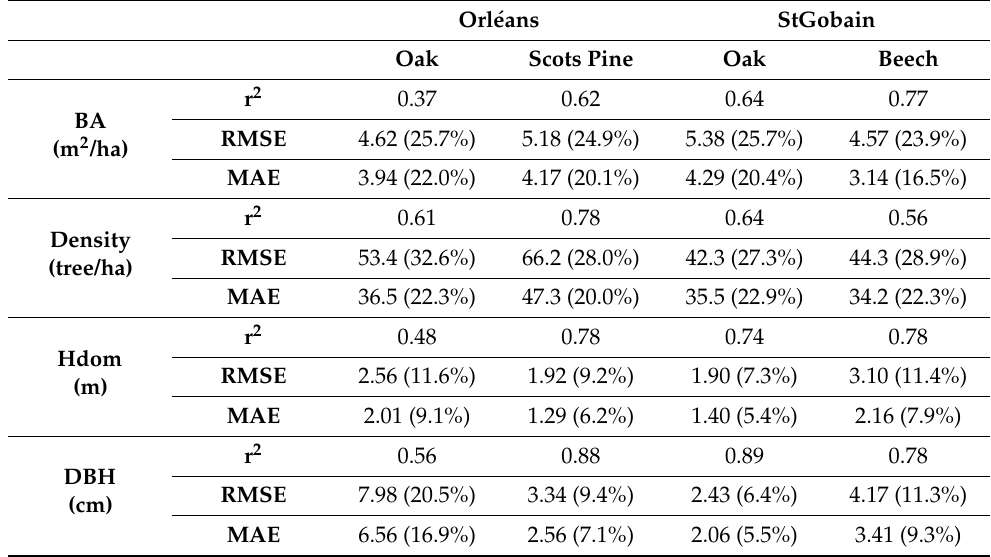
Table A1. Cross-validation statistics of the estimation of basal area (BA), tree density (Density), dominant height (Hdom) and mean DBH